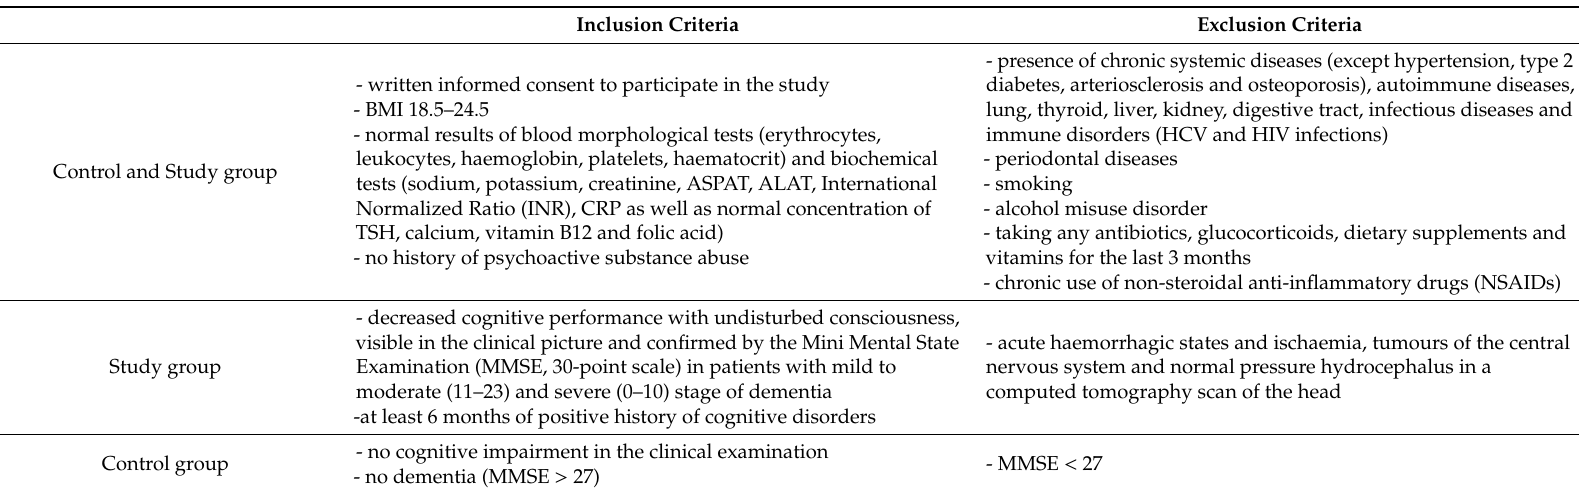
Table 1. Inclusion and exclusion criteria for dementia patients and the control group. Abbreviations: ALT—alanine transferase; ASPAT—aspartate